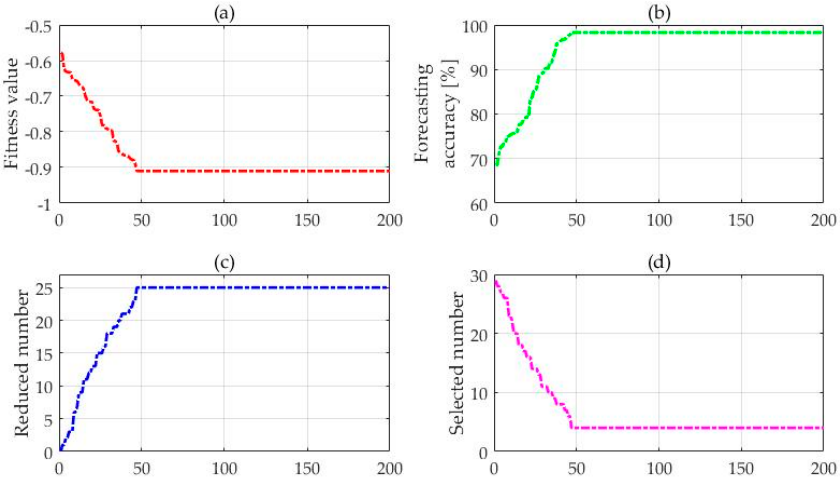
Figure 9. Original data chart of icing thickness, temperature, wind speed and humidity. Note: ( a ) represents the original data of icing thickness; ( b ) represents the original data of temperature; ( c ) represents the original data of wind speed; and ( d ) represents the original data of humidity.